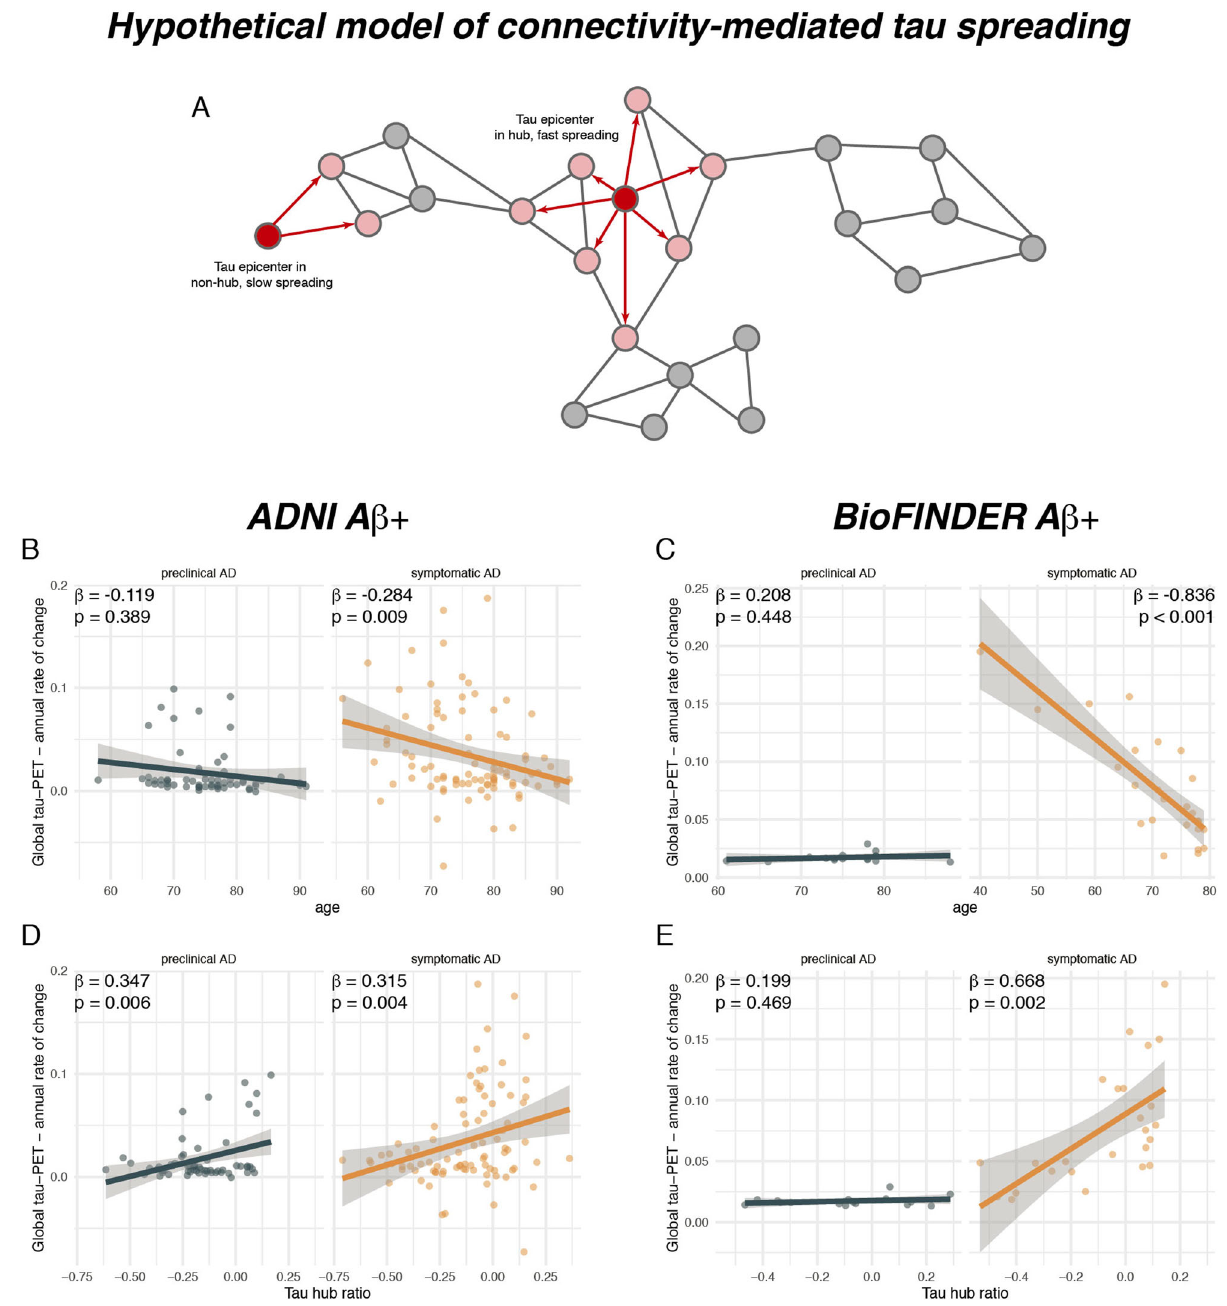
Fig. 4 | A higher tau hub ratio facilitates tau spreading. A Schematic illustration ofahypotheticaltauspreadingmodel.Whentauepicentersfallinahubregionwith manyconnectionstootherregions,tauspreadshouldbefasterascomparedtotau spread from an epicenter in a non-hub region with fewer connections. The asso- ciationbetweenageand annualtau-PETchangeratesforA β +subjectsisillustrated in B for the ADNI ( N =147) and C for the BioFINDER sample ( N =41), strati fi ed by